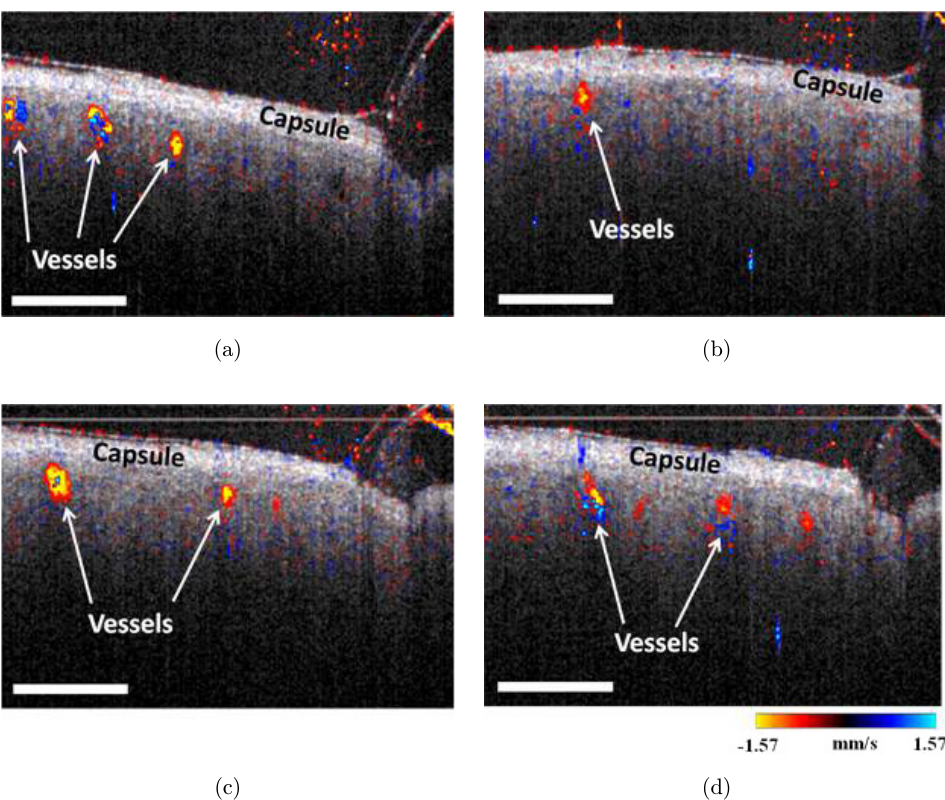
Fig. 6. OCT/DOCT imaging of in vivo kidney. Blood °ow is seen in numerous cortical vessels but uriniferous tubules appear to be closed and not visible in adjacent image regions. Data are from another patient di®erent from that shown in Fig. 4. Scale bar ¼ 500 (cid:1)